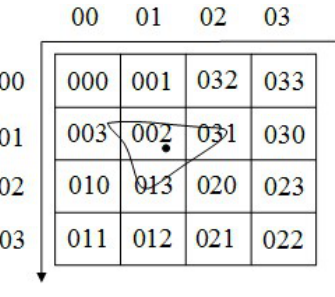
Figure 1. Spatial entity division.